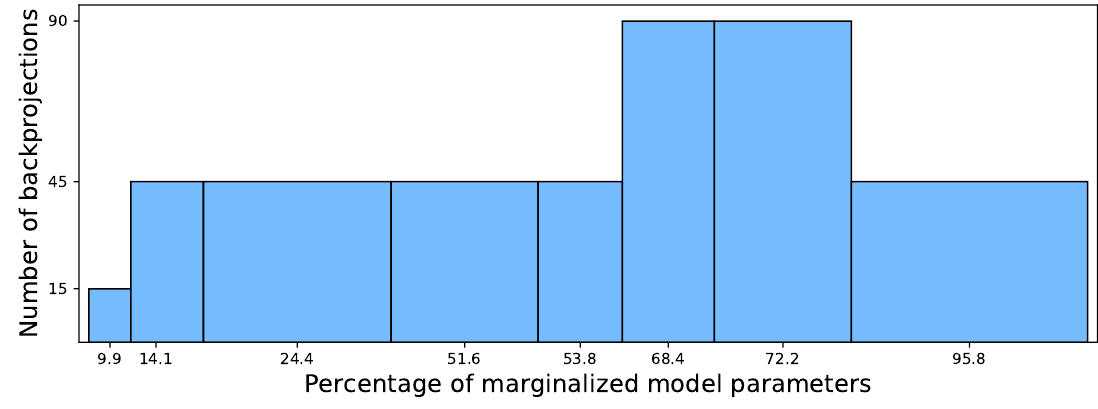
Figure 5. Percentages of model parameters lost during